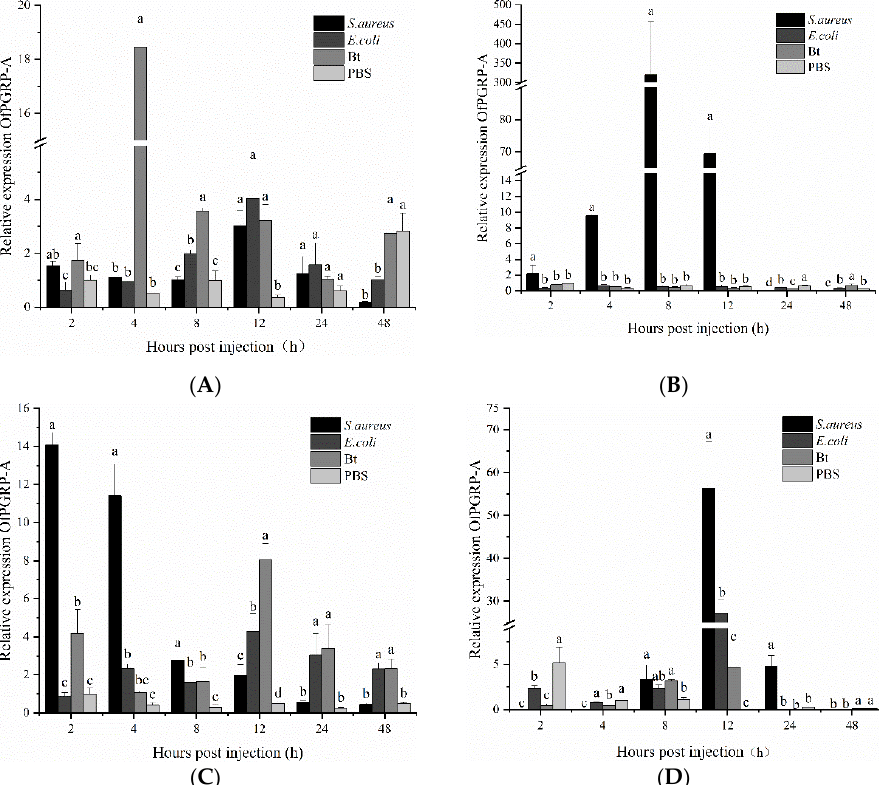
Figure 5. Expression levels of OfPGRP-A in different tissues of 4th instar larvae of Ostrinia furnacalis after injection with different pathogens: ( A ) epidermis; ( B ) hemolymph; ( C ) fat body; ( D ) midgut. PBS: PBS buffer; Bt: Bacillus thuringiensis ; Staph: Staphylococcus aureus ; RIL: Escherichia coli. The small letters represent a signifificant difference (one-way ANOVA, followed by Tukey’s test as post hoc, p < 0.05).